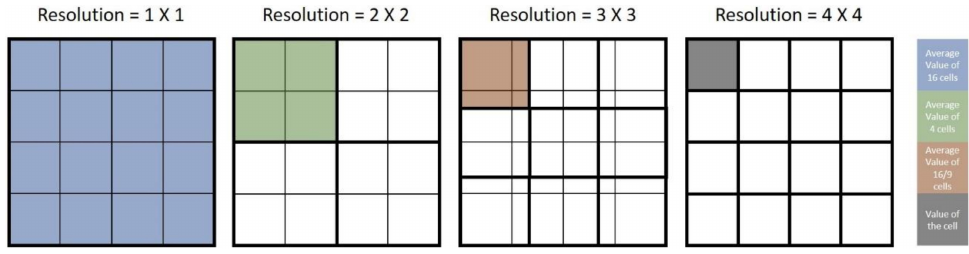
Figure 12. The instruction of the density value computing and the relationship between it and image resolutions.